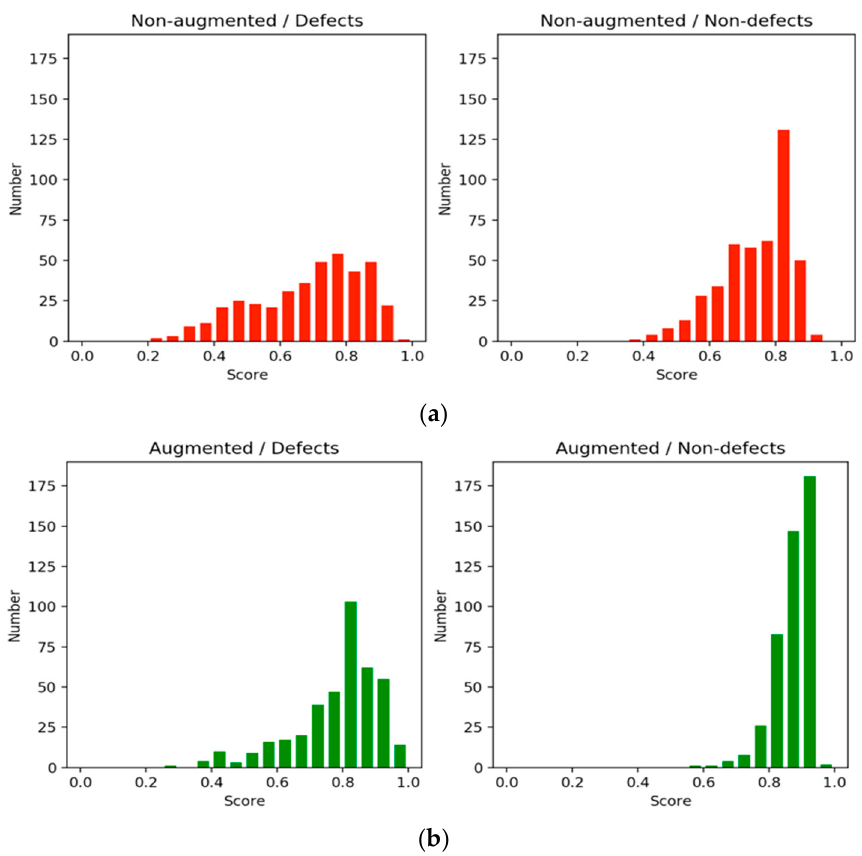
Figure 8. Comparison of the score distribution. ( a ) Nonaugmented method and ( b ) augmented method.